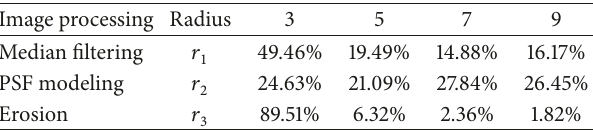
Table 2: The coefficients among the image descriptors and opti- mized binary